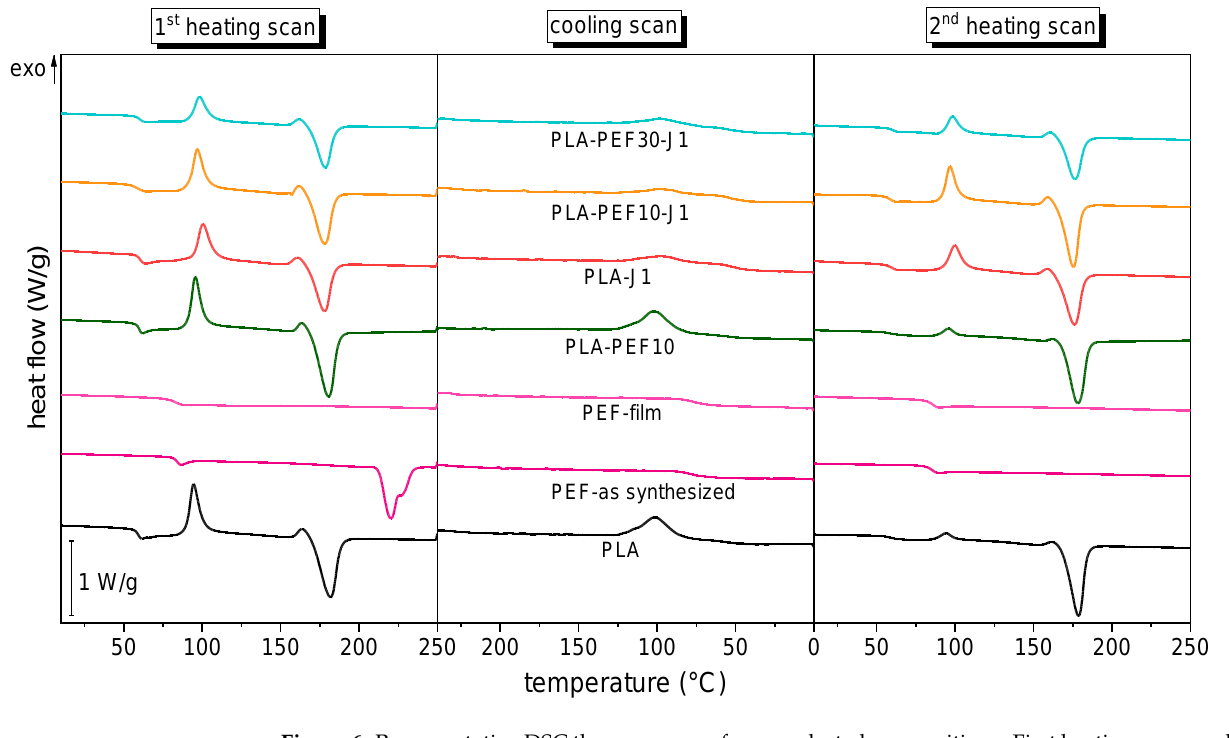
Figure 6. Representative DSC thermograms of some selected compositions. First heating scan, cooling scan, and second heating scan. Table 4. Main results of the DSC tests on the prepared samples. All properties refer to the PLA phase, except for the samples composed of neat PEF (*).